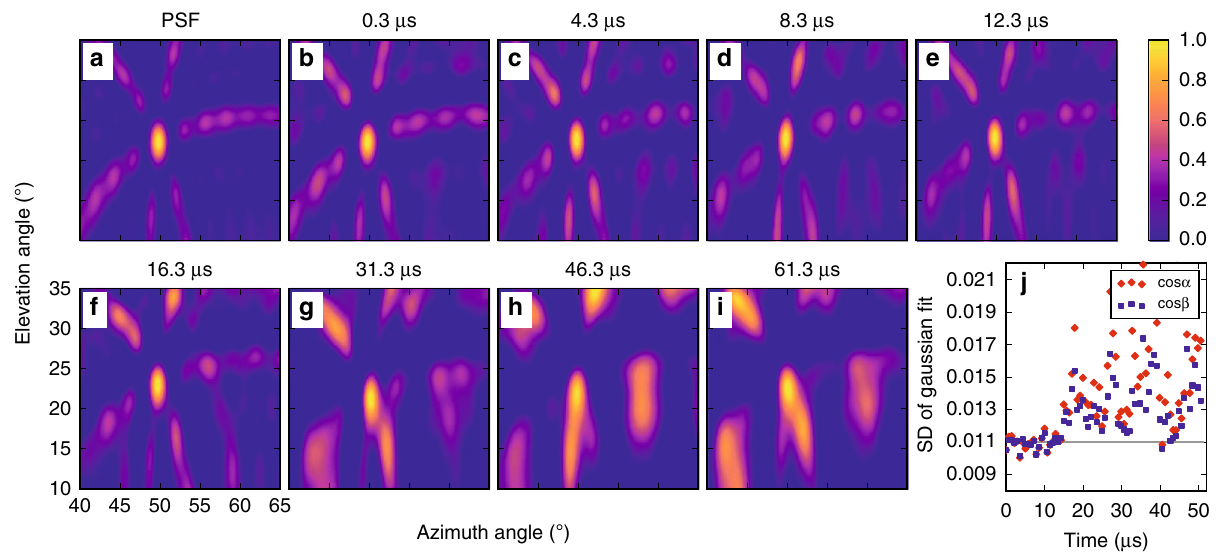
Fig. 5 Radio images of NBE 2. Elevation vs. azimuth images of ( a ) an ideal point source at NBE 2 ’ s location ( Az , E ‘ = 50°, 23°), called the point spread function (PSF), b – e sample images at ≃ 4 μ s intervals during the fi rst 15 μ s of NBE 2, corresponding to its upward fast negative breakdown (FNB) phase, and f – i sample images during successive 15- μ s intervals. In each case, the images are 0.7- μ s exposures, normalized to the peak amplitude of the centroid. The central lobe of the PSF shows the angular resolution of the three-antenna array and, along with the side lobes, remains essentially unchanged during the FNB, consistent with the VHF radiation being from a localized source. Following the FNB, the central lobe becomes increasingly elongated and the side lobes intensify and become disorganized, indicative of extended and/or multiple radiation sources. j Standard deviations (SDs) of the central lobe in the (cos α , cos β ) projection plane vs. time (red, blue symbols), compared to the SDs of the PSF function (gray line), quantitatively showing the radiation to be localized during the FNB and increasingly non-localized and random subsequent to the